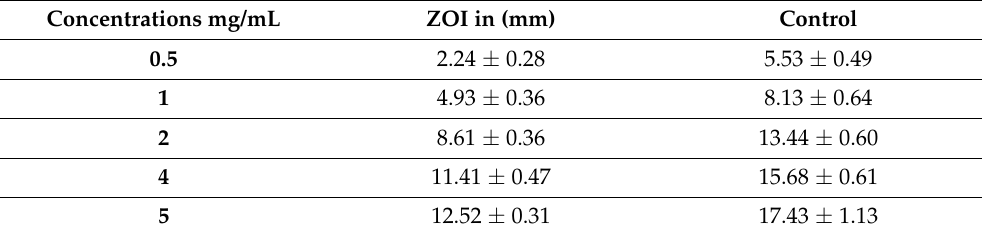
Table 6. Protein kinase inhibition potential of FeNPs.